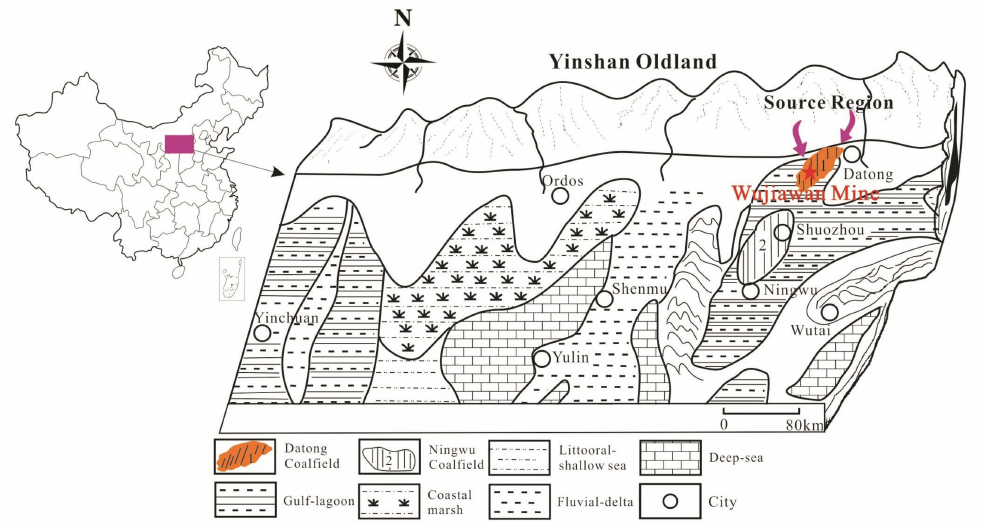
Figure 1. Paleogeographic setting and location of the Datong coalfield and Yinshan Oldland in the late Paleozoic. Modified from Sun et al. [9].